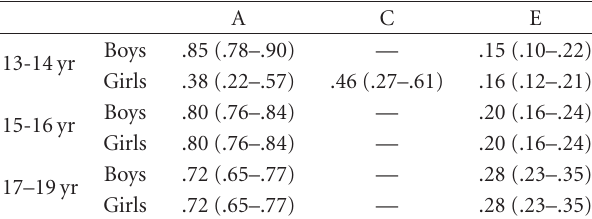
Table 5: Proportions of variance explained by additive genetic, common environmental and unique environmental factors from the best-fitting models for exercise participation in three-age groups for boys and girls (95% confidence intervals added in